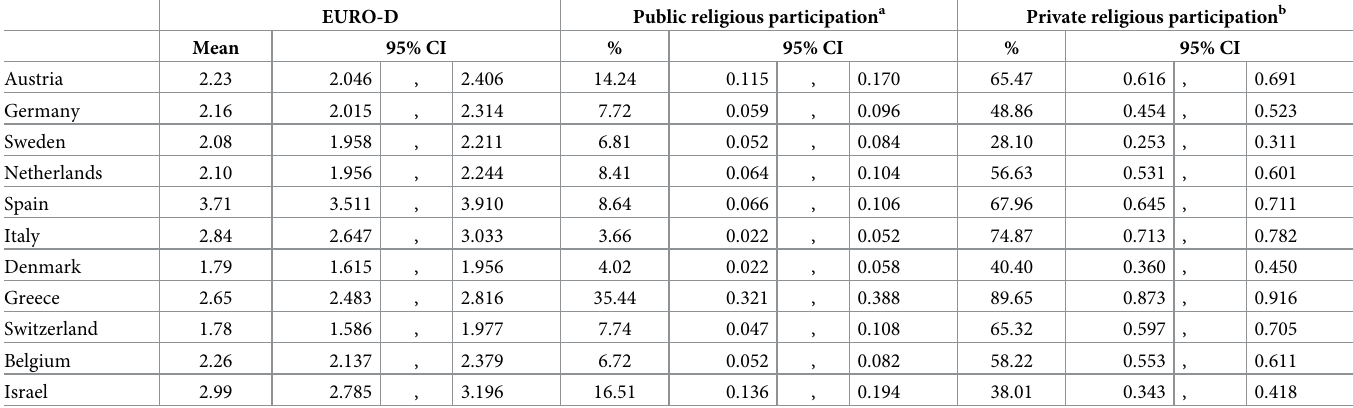
Table 2. Baseline mean depression scores and public and private religious participation by